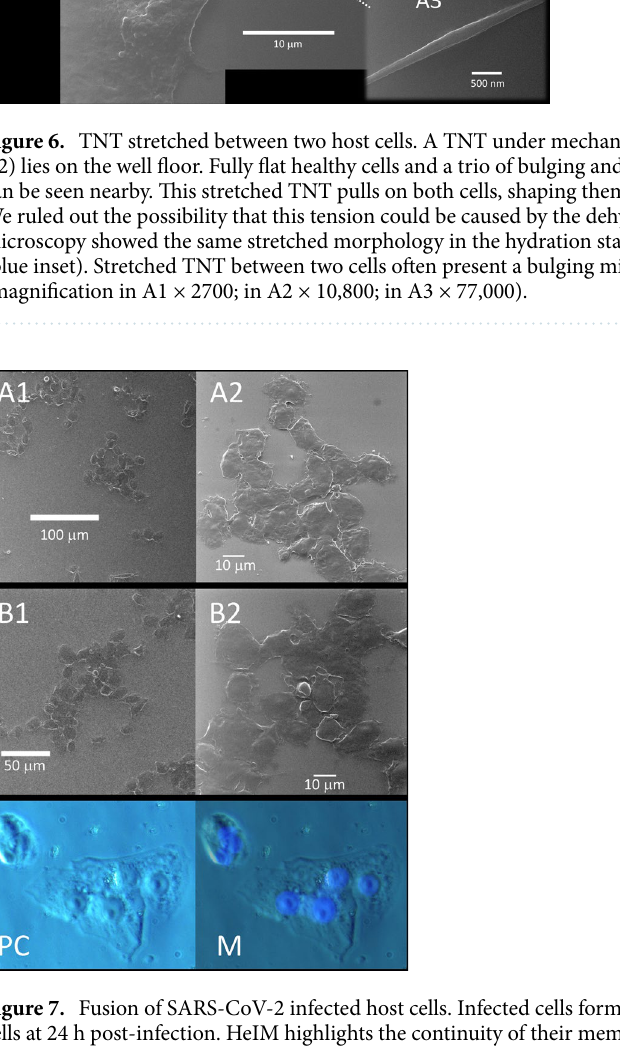
Cell fusion. The virus propagating within Vero E6 cells causes severe cytopathic effect (CPE) 5 . It is possible that the uninfected cells that lie flat over the well-floor, can swell and detach from the floor, may fuse together and may form TNT. We identified that SARS-CoV-2 infected Vero E6 cells can form large-scale (submillimeter) clusters of multiple fused cells (syncytia) at 24 h post-infection. This type of fusion is not observed in uninfected cells. HeIM provided images of the homogeneous continuity of the membrane of the syncytia (Fig. 7A,B). Cor- relative microscopy showed the presence of multiple nuclei, identified by their specific fluorescent marker DAPI, in these clusters of cells (Fig. 7). Extracellular vesicles. Many spherical vesicles whose diameter ranged from about 30 nm to more than 1 micron have been observed both in SARS-CoV-2 infected and uninfected Vero E6 cells, apparently in simi- lar numbers (Figs. 1, 8). We documented the extracellular vesicles when they bud from the cell membrane (Figs. 1A3,B3, 8D), or while they are in contact with the membrane (Fig. 8A,C), or as free objects in the extracel-